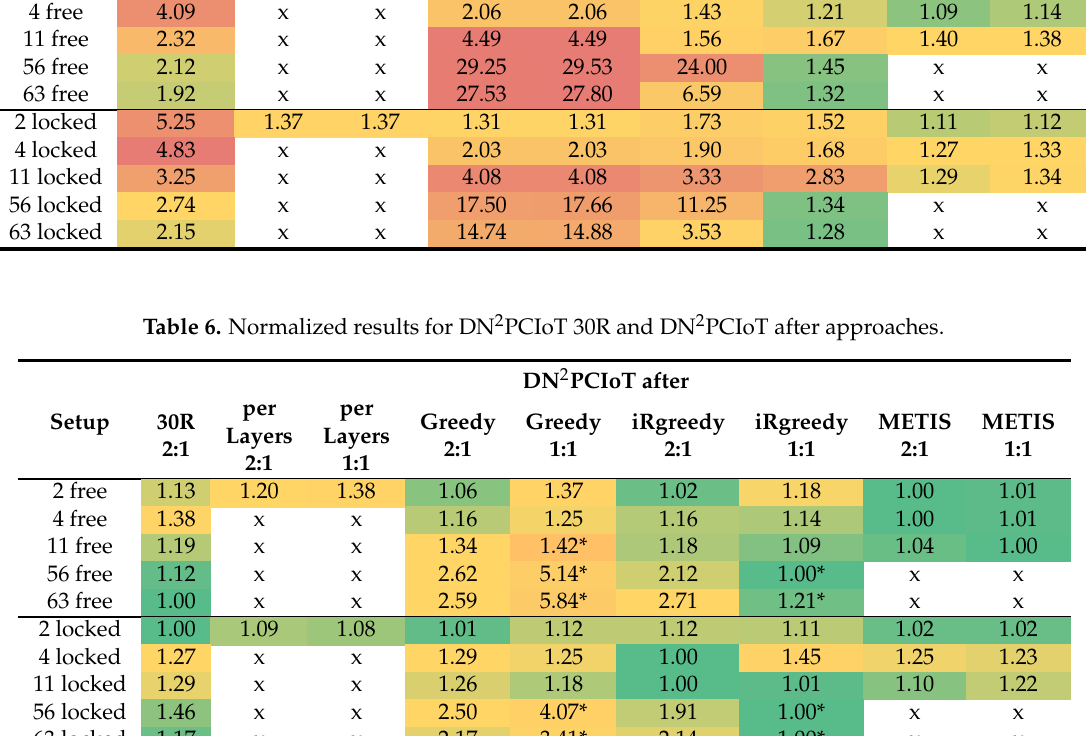
Table 5. Normalized results for the naive approaches. The minimum and maximum consider Tables 5 and 6. Median Per Per Greedy Greedy iRgreedy iRgreedy METIS METIS Setup of 30 Layers Layers